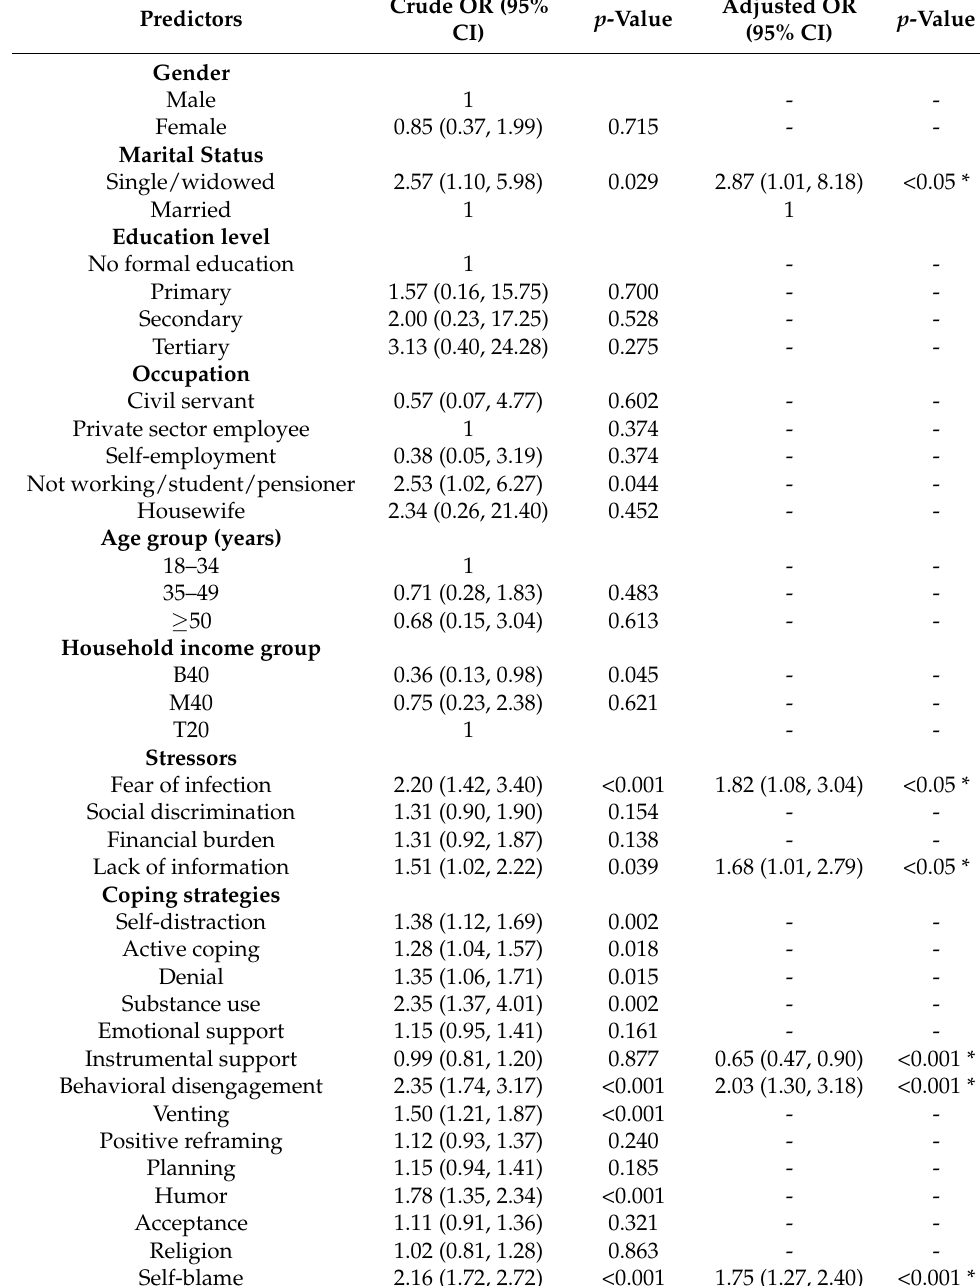
Table 3. Simple and multiple logistic regression of anxiety among hospitalized patients with